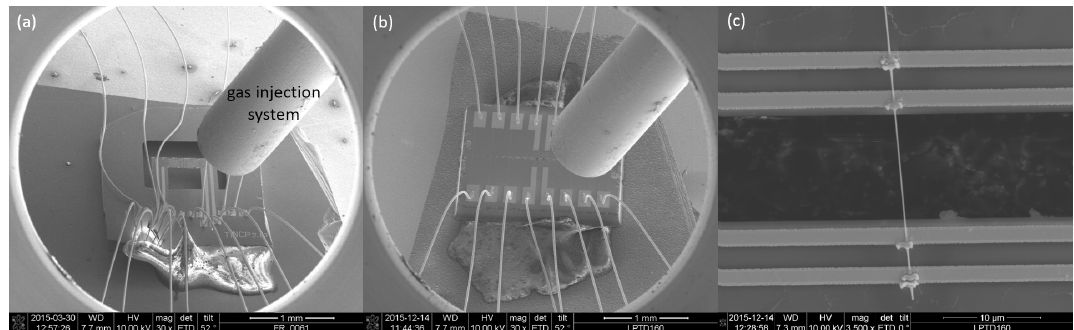
Figure 2. ( a , b ) TNCPs a and b in the focused electron beam-induced deposition (FEBID)